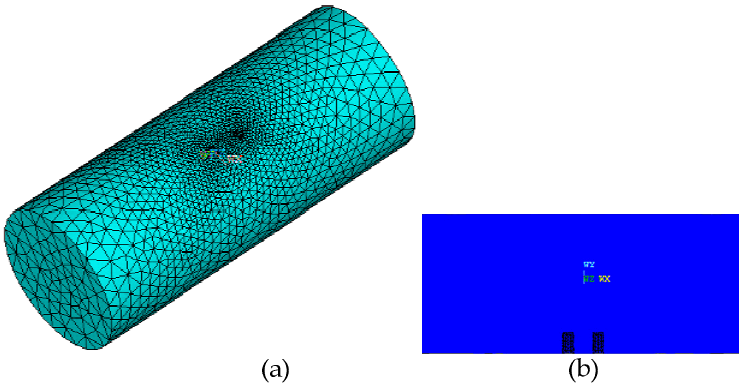
Figure 2. The meshed 3D model of the MCP with 26,695 elements, L = 0.05 m, D = 0.02 m, S = 0.004 m, d =0.0015 m, h = 0.002 m, water resistivity σ w = 100 Ω ·m: ( a ) 3D model; ( b ) the axial section.